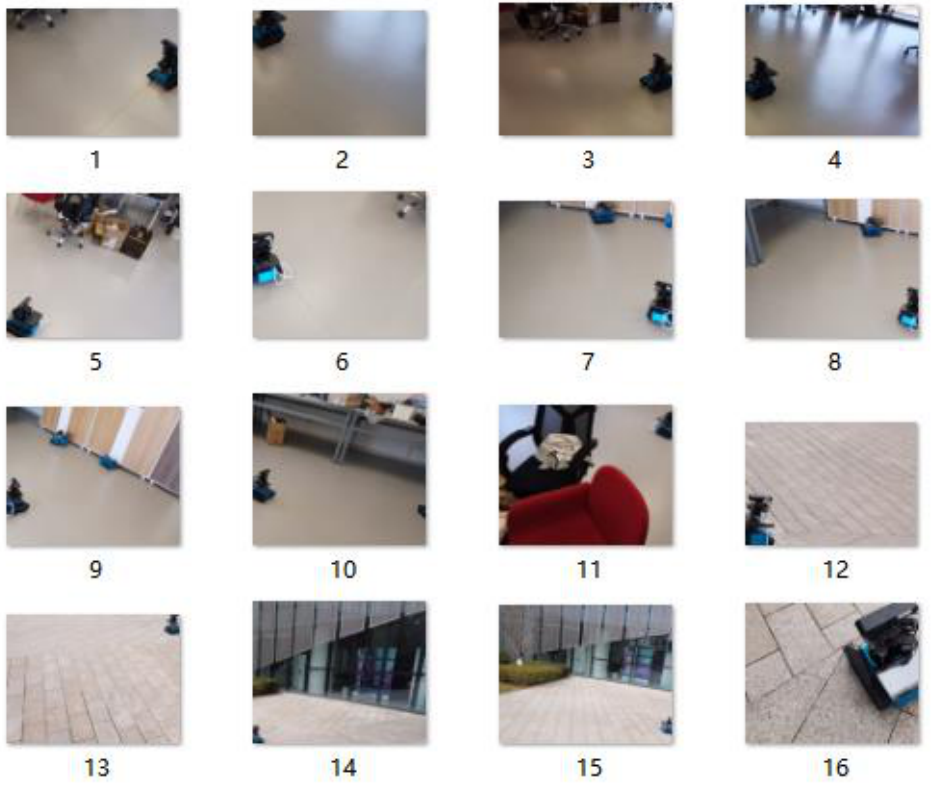
Figure 2. Examples of testing data set 2.